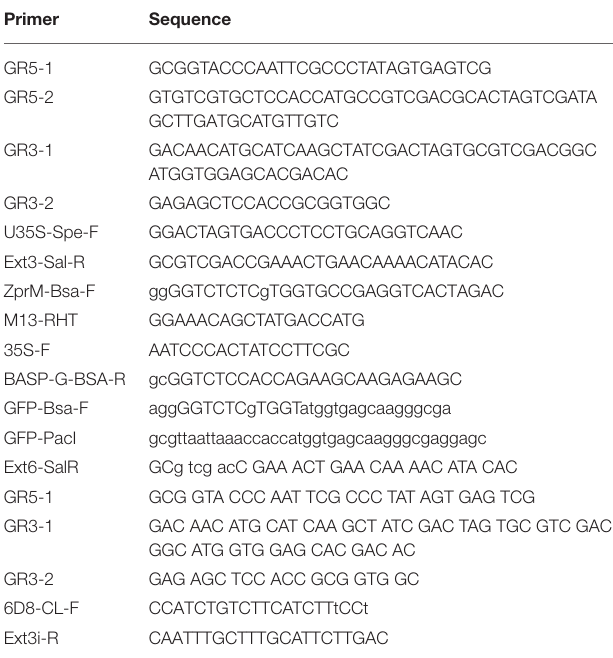
TABLE 1 | Oligonucleotides used in this study.